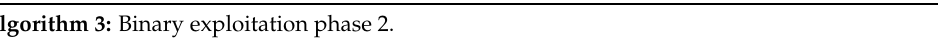
Algorithm 3: Binary exploitation phase 2.